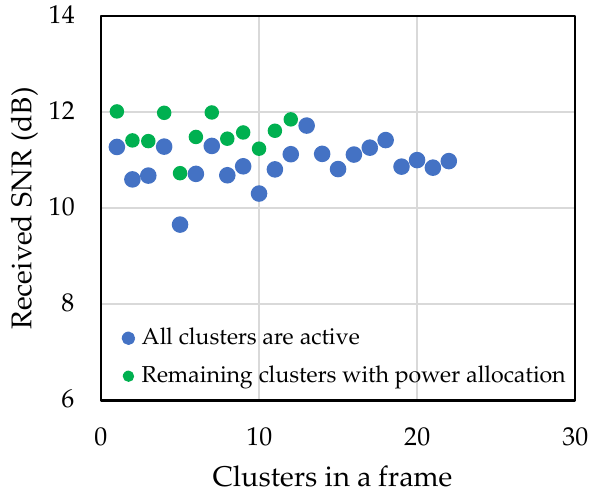
Figure 16. Estimated received SNR of the clusters of a frame.